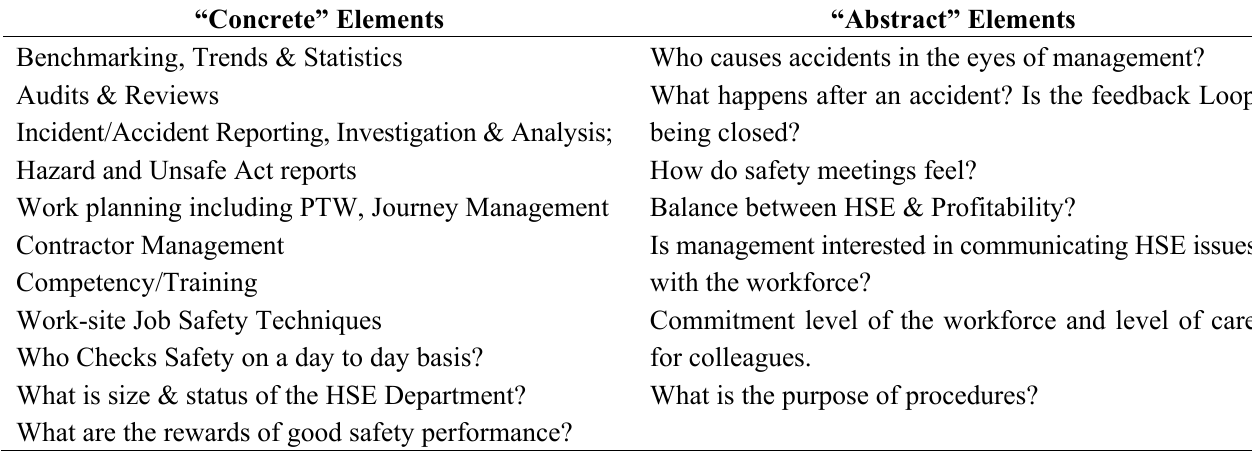
Table 1. Elements of safety culture within Hudson maturity model